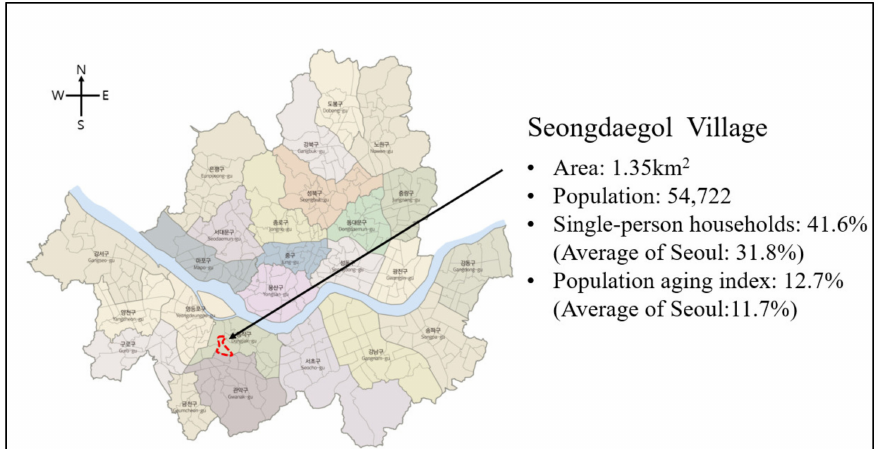
Figure 2. Location of Seongdaegol village in Seoul. (Source: Reference from the white paper of SLL